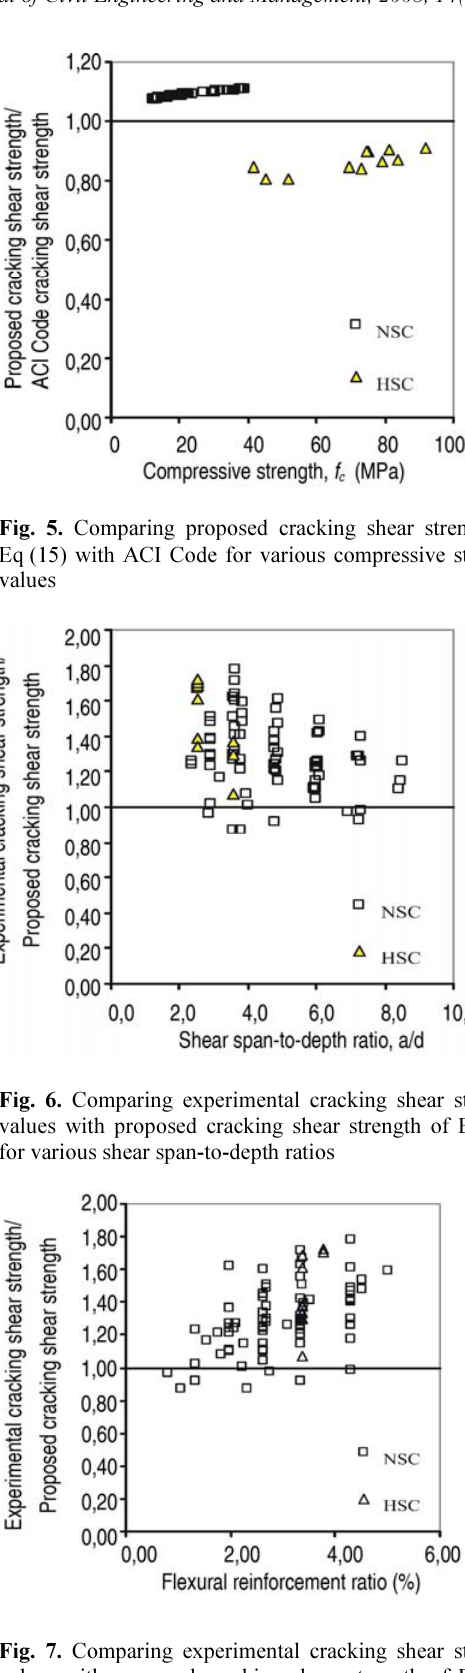
Fig. 7. Comparing experimental cracking shear strength values with proposed cracking shear strength of Eq (15) for various flexural reinforcement ratios